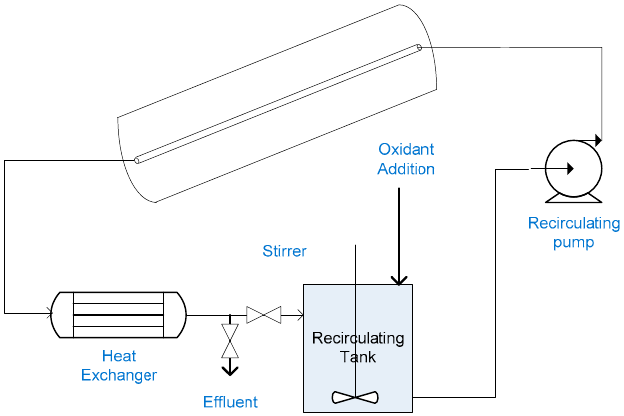
Figure 1. Schematic drawing of PTR (Parabolic Trough reactor) system.